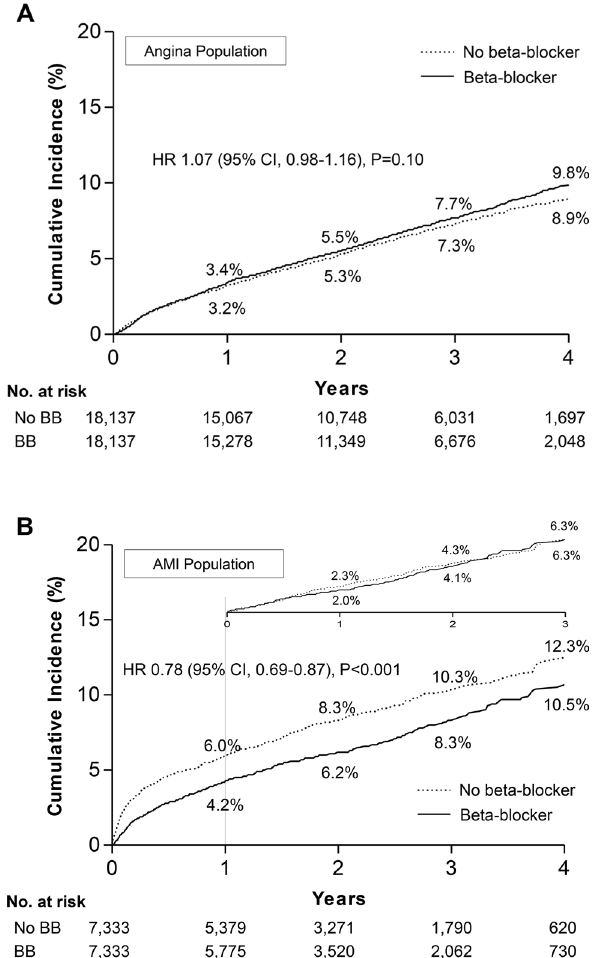
Figure 2. Kaplan–Meier cumulative event curves for mortality in the matched cohort. The cumulative incidence rates for all-cause death between the beta-blocker and no beta-blocker therapy groups in patients with AMI ( a ) and those with angina ( b ). The numbers in each figure represent the cumulative incidence rates at each time point. AMI, acute myocardial infarction; BB,